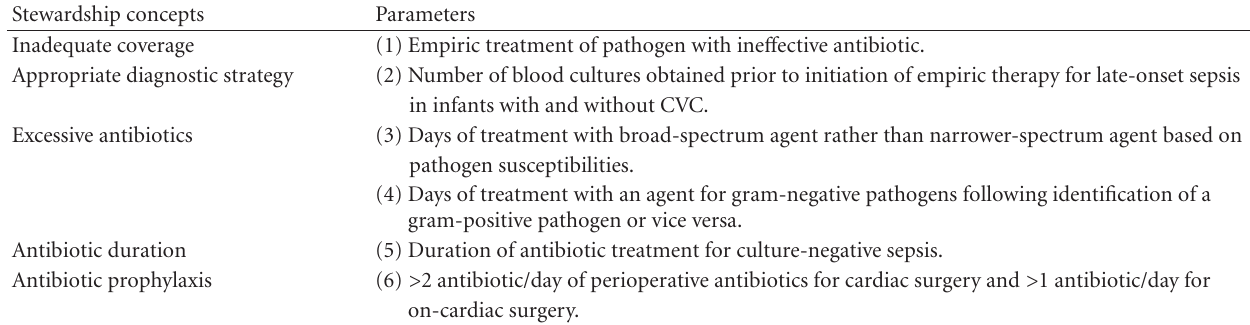
Table 1: Parameters of antibiotic prescribing studied in audit and feedback intervention used in the neonatal intensive care unit. Stewardship concepts